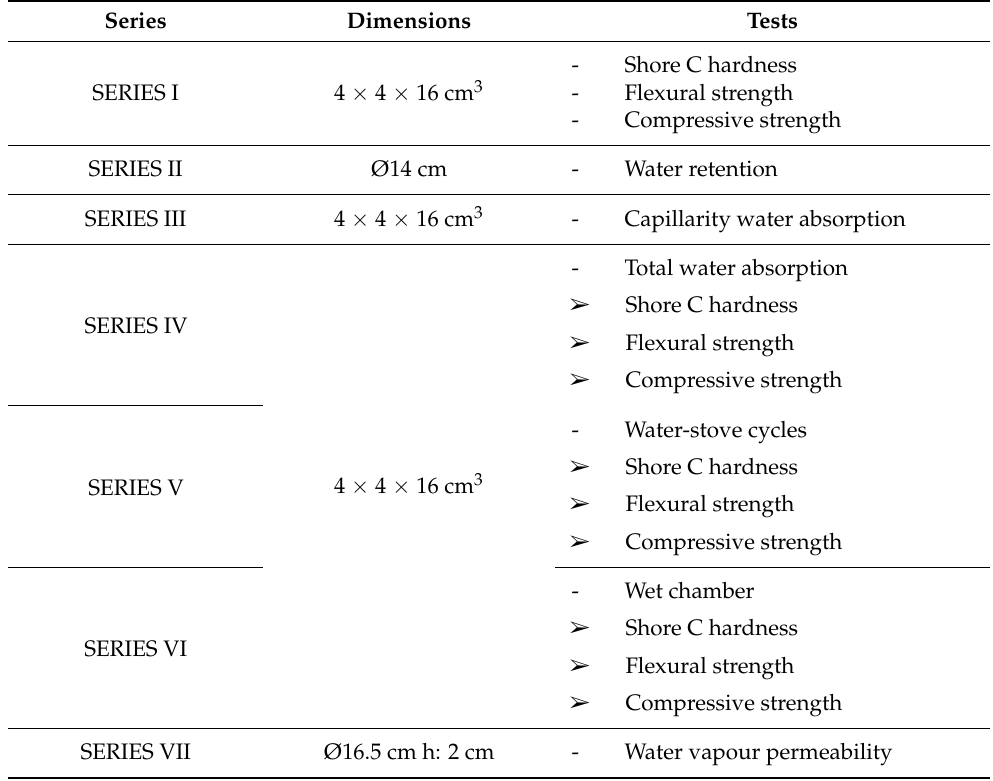
Table 4. Samples elaborated and their